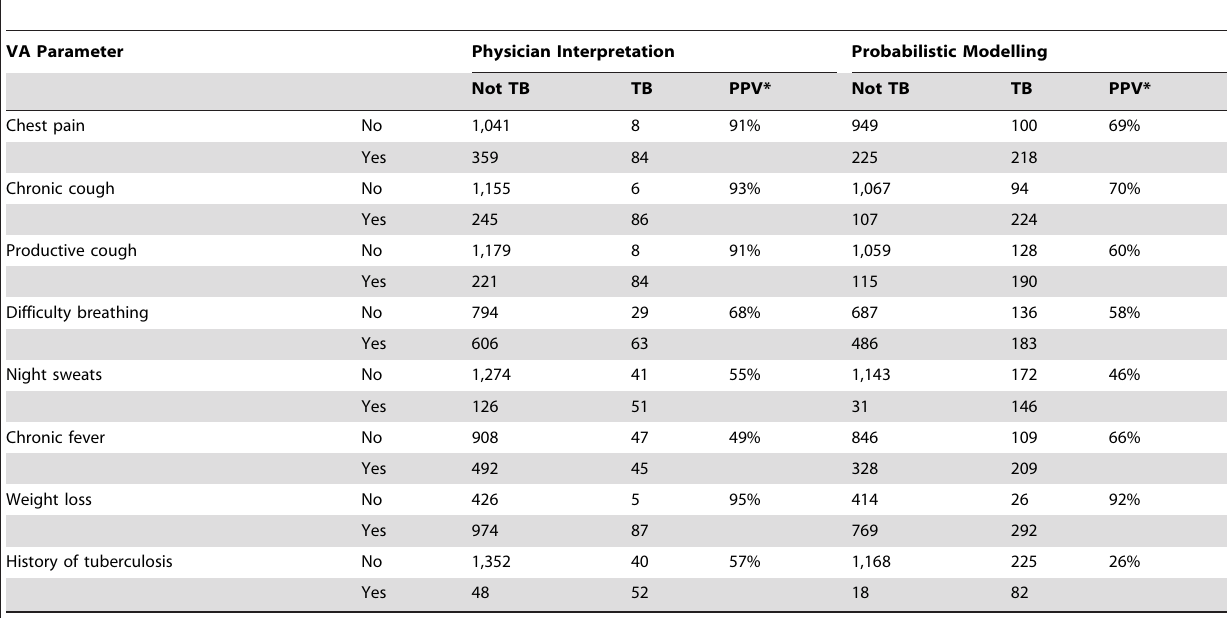
Table 3. Pulmonary tuberculosis as a possible cause of death among 1,492 elders (65 + years) as interpreted by physician consensus (6.4%) and probabilistic modelling (21.3%), in relation to selected verbal autopsy parameters.